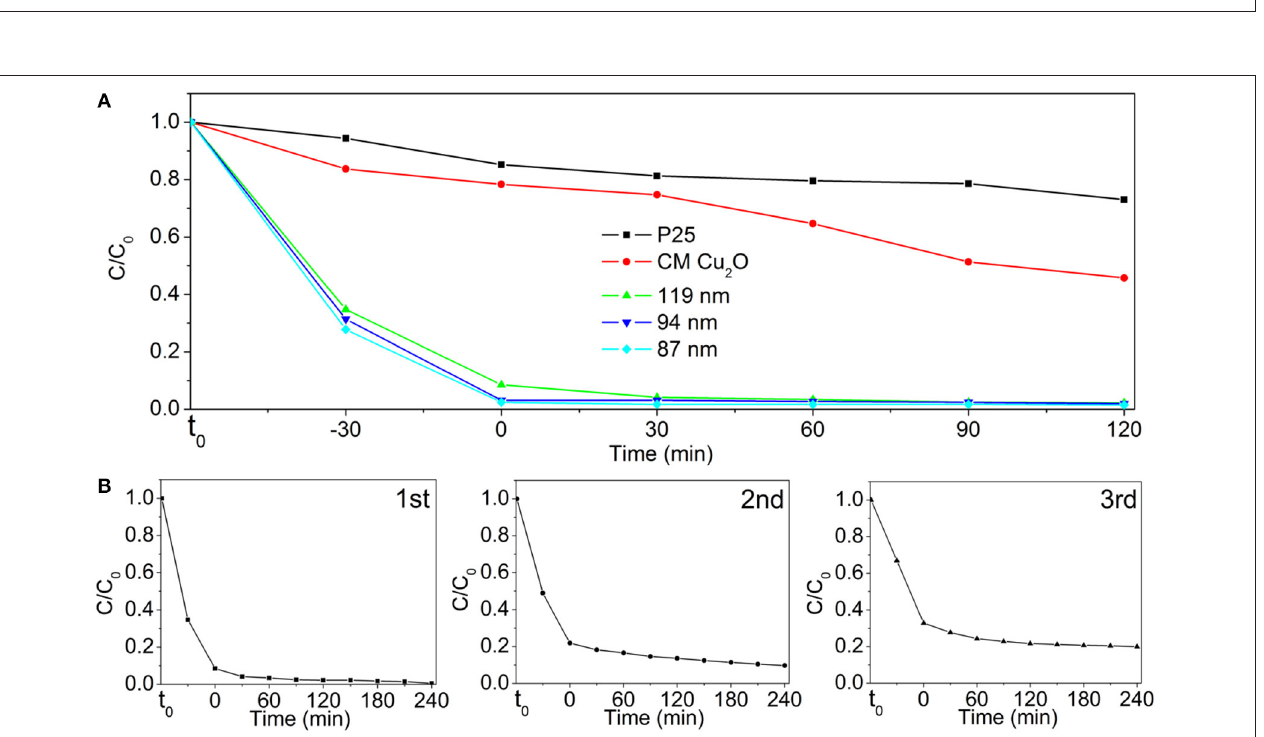
FIGURE 6 | (a,c) Low- and (b,d) high-magnified SEM images of products obtained via the standard procedure, except that the volume of Au seed stock solution was set to (a,b) 1,000 µ l and (c,d) 500 µ l, respectively.